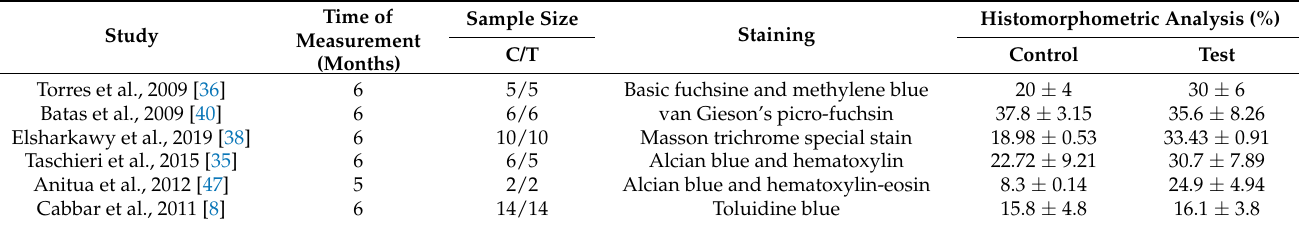
Table 2. Histomorphometric analysis of the included